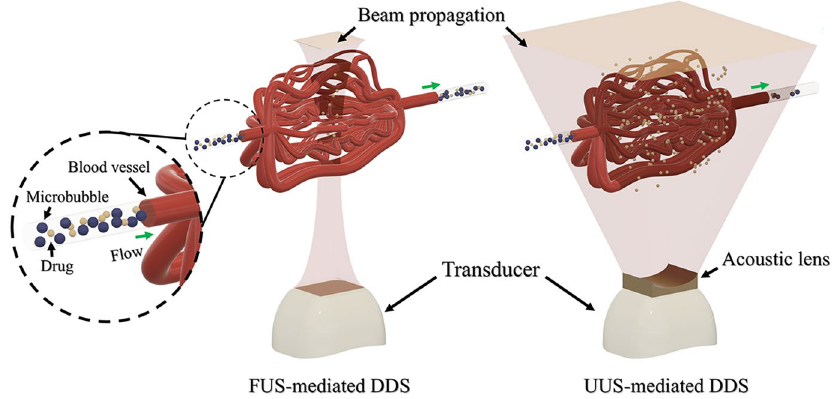
Figure 1. Schematic of the focused ultrasound-mediated drug delivery system (FUS-mediated DDS) and unfocused ultrasound-mediated drug delivery system (UUS-mediated DDS) with the designed acoustic